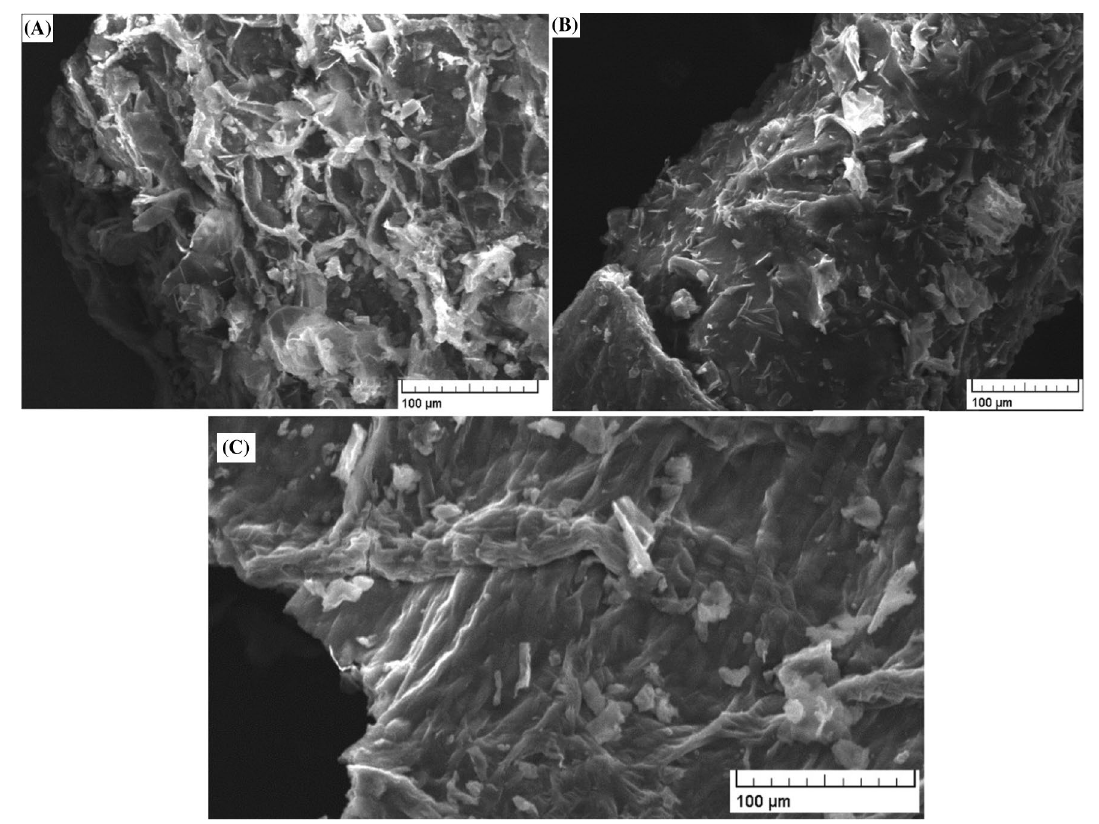
Fig. 2 SEM images displaying the surface morphologies of a WL, b TP and c CP at ×500 magnification